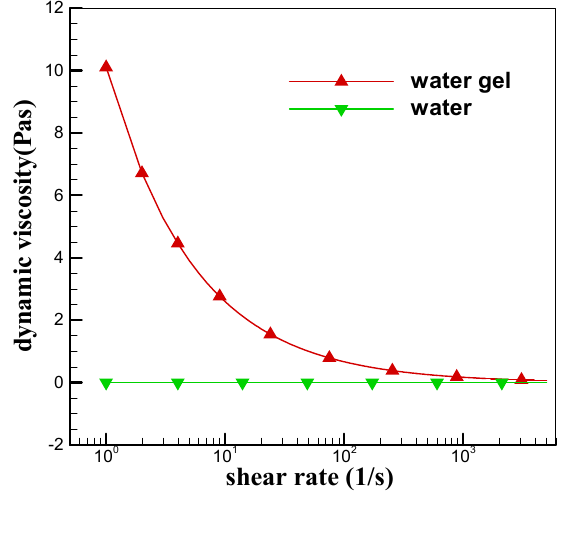
Figure 3. Semi-log plot of the viscosity of water based simulants and water.